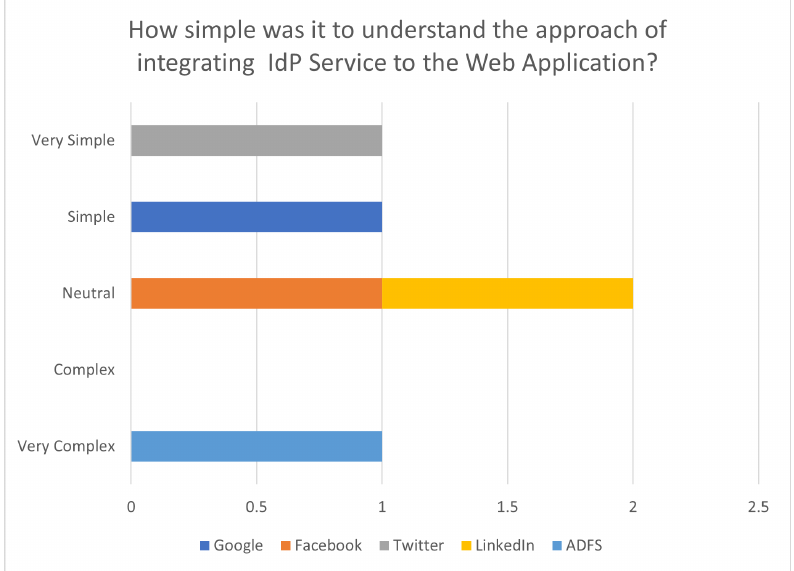
Figure 8. How simple was it to understand the approach of integrating IdP Service to the Web